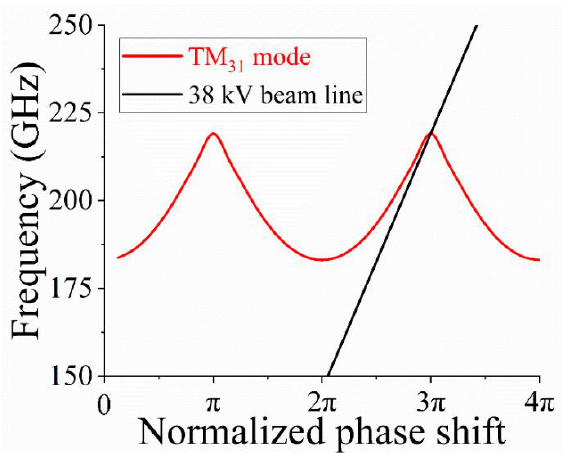
Figure 4. The dispersion curve of the coaxial multiple-beam EIO and 38 kV beam line. Table 1. Period lengths and gap lengths of various G-band extended interaction devices.